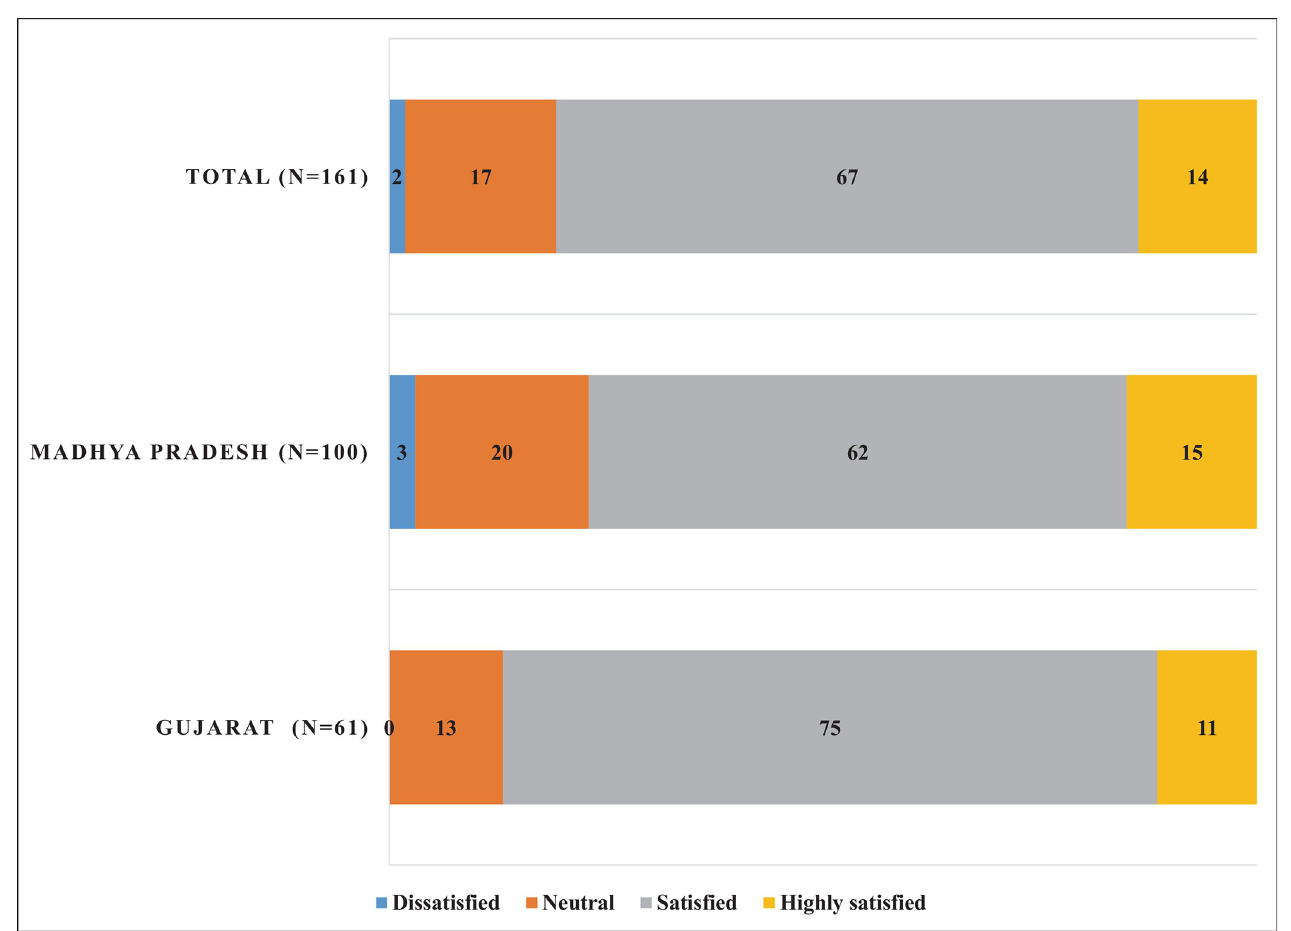
Fig 2. Proportion of beneficiaries by their level of satisfaction with registration: A comparison across states (In